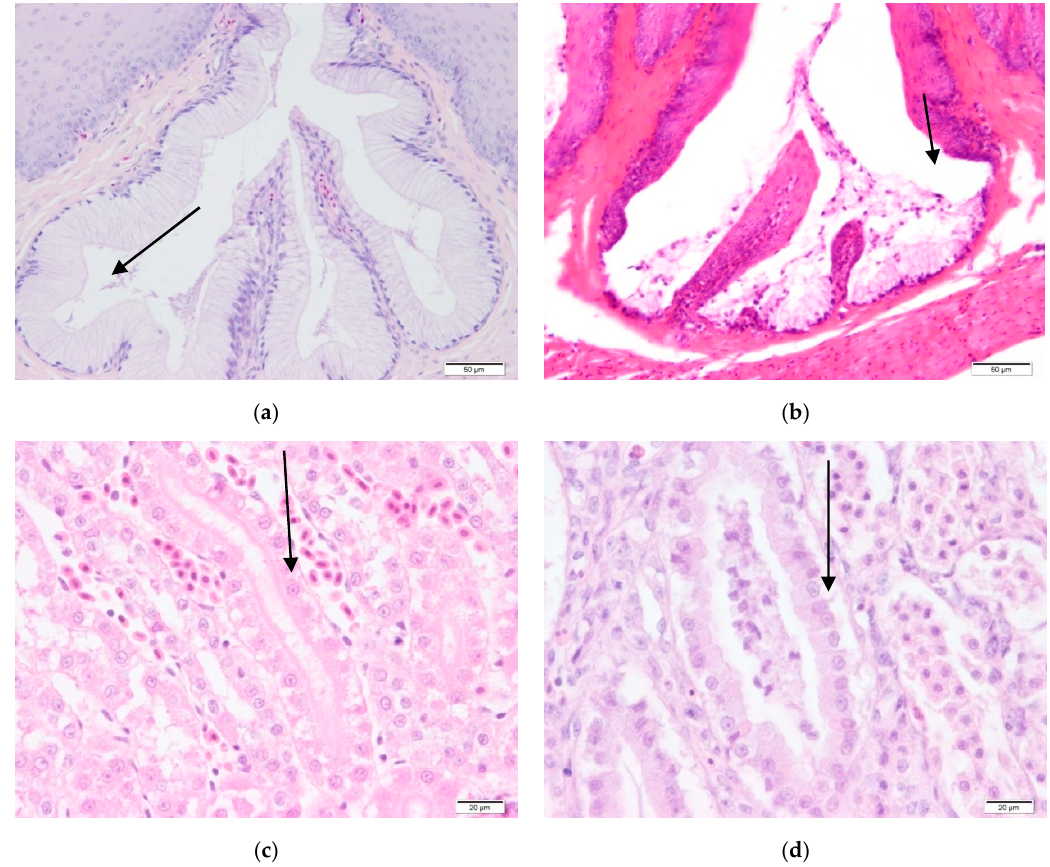
Figure 2. Microscopic lesions of tissues from control ( a,c ) and experimental birds ( b,d ). ( a ) Normal oesophageal mucosa and mucus glands (arrow). ( b ) Oesophagus with hyperplastic, thickened mucosa and submucosal squamous metaplastic mucus glands (arrow). ( c ) Normal renal tubules (arrow). ( d ) Mild degeneration in renal tubules (arrow).